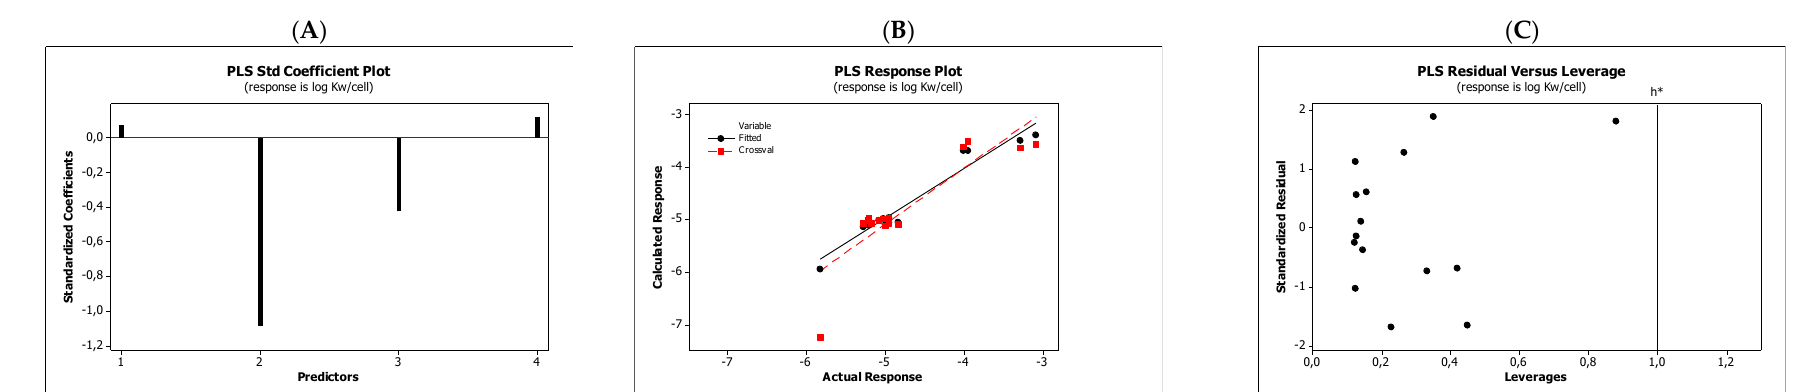
Figure 6. Standardized coefficients ( A ), the correlation between actual and predicted log K w/cell parameters ( B ), and the Williams plots ( C ) of Equation (5).